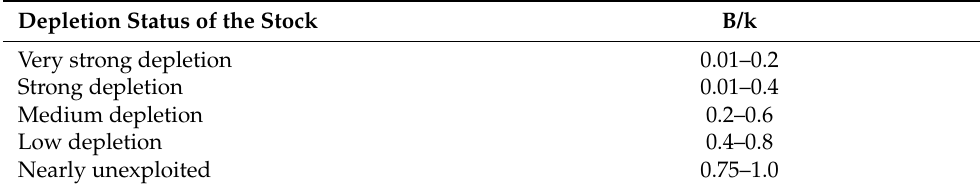
Table 2. Prior relative biomass (B/k)